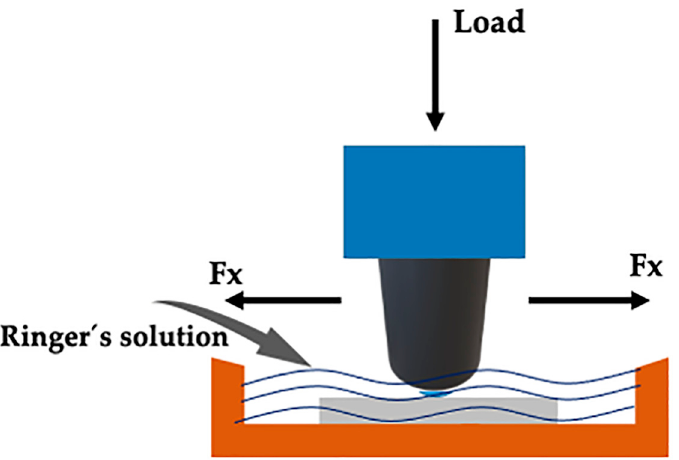
Figure 3. Schematic illustration of the UMT wear test device, with immersion of the sample in Ringer’s lactate solution.